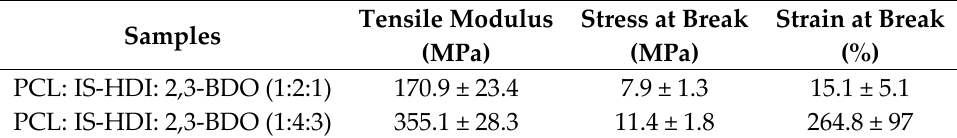
Table 2. Mechanical properties of synthesized